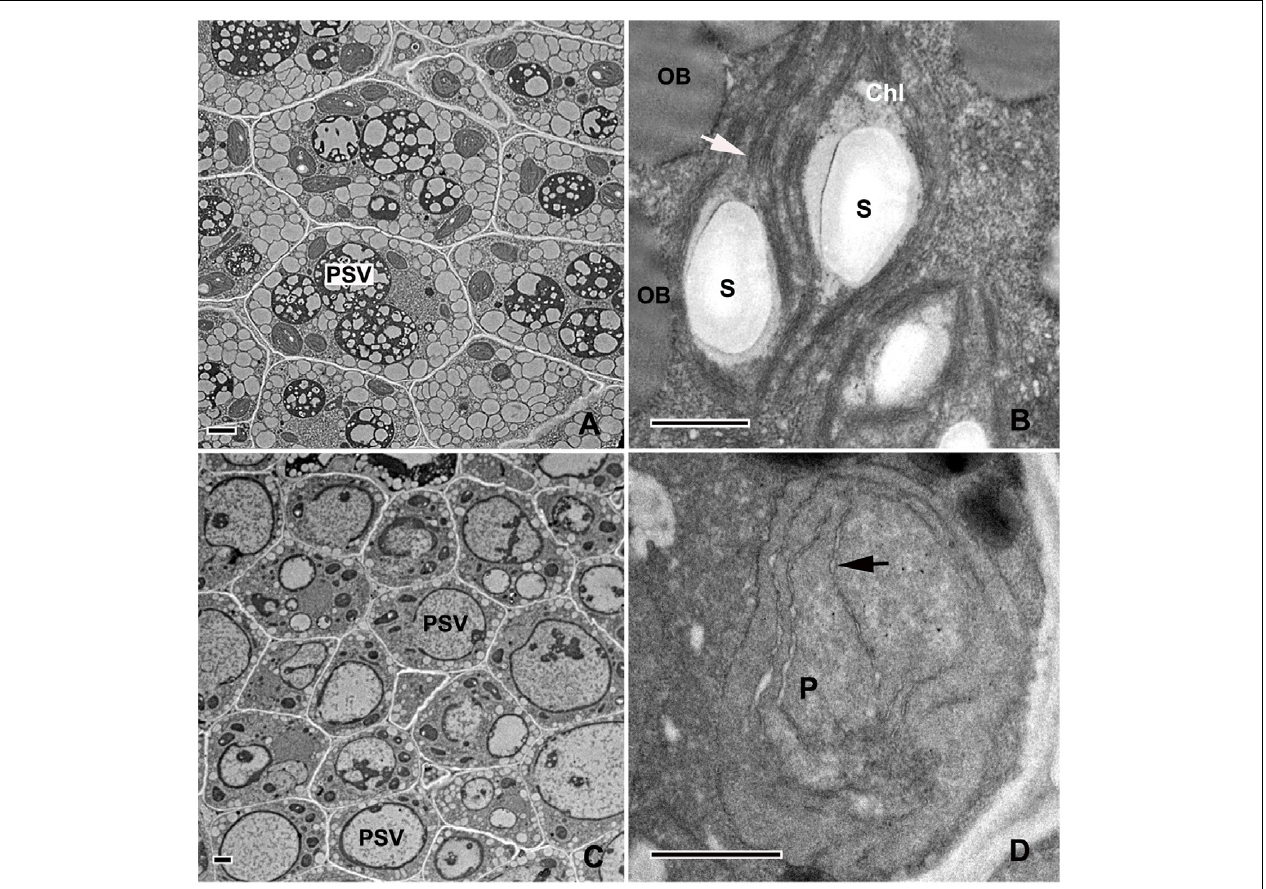
FIGURE 4 | Analysis of the ultrastructure of plastids in 10-DAP embryos. Ultrathin sections of both control (A,B) and treated (C,D) embryos growing after 10 DAP were analyzed with a Hitachi-7650 transmission electron microscope. The white arrow indicates the internal membrane system (grana and stromal thylakoids in chloroplast. The black arrowhead indicates poorly developed single thylakoid membranes in dark-forced plastids. PSVs, protein storage vacuoles; Chl, chloroplast; P, plastid; S, starch grains; OB, oil bodies. Scale bar: A,B = 1 µ m; C,D = 500